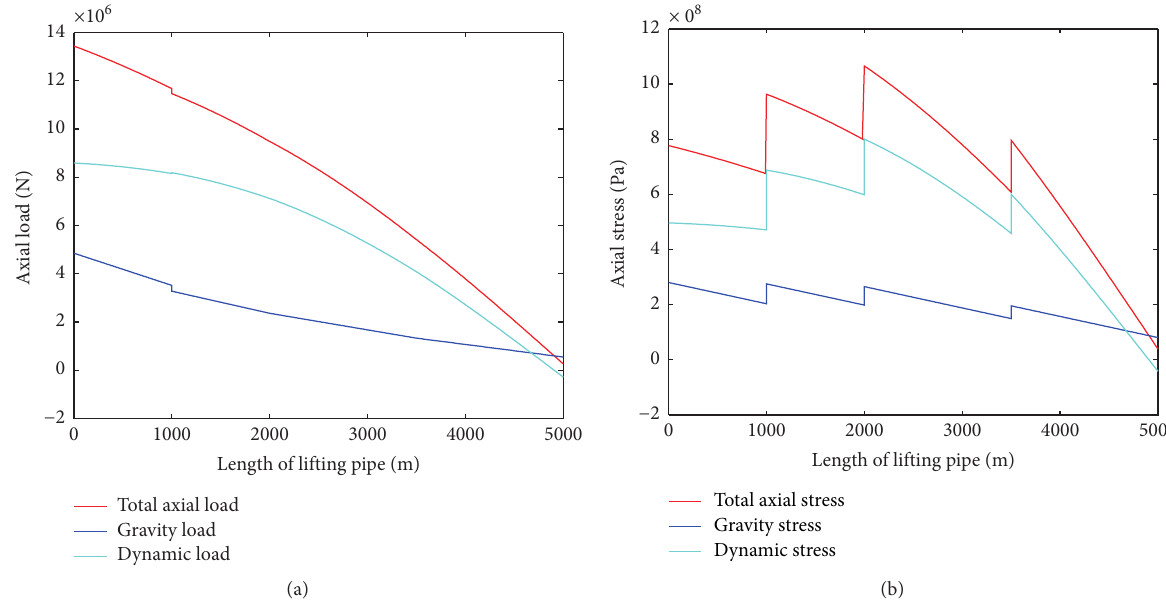
Figure 13: Axial load and stress with DVA. (a) Axial load. (b) Axial stress.